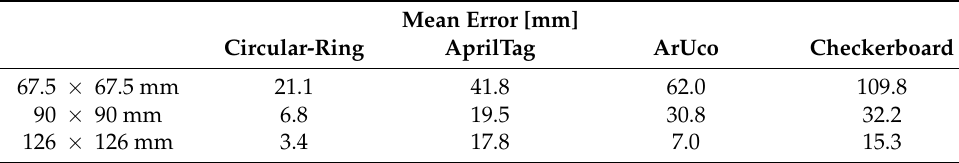
Table 7. Comparison of positioning accuracy under different dimensions.